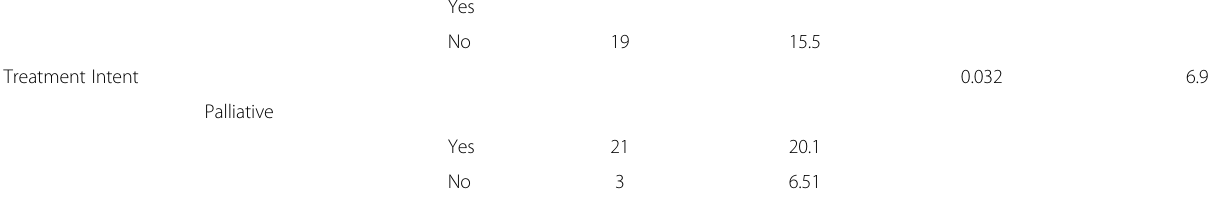
Table 2 Contingency table of Patient characteristics and CAM use